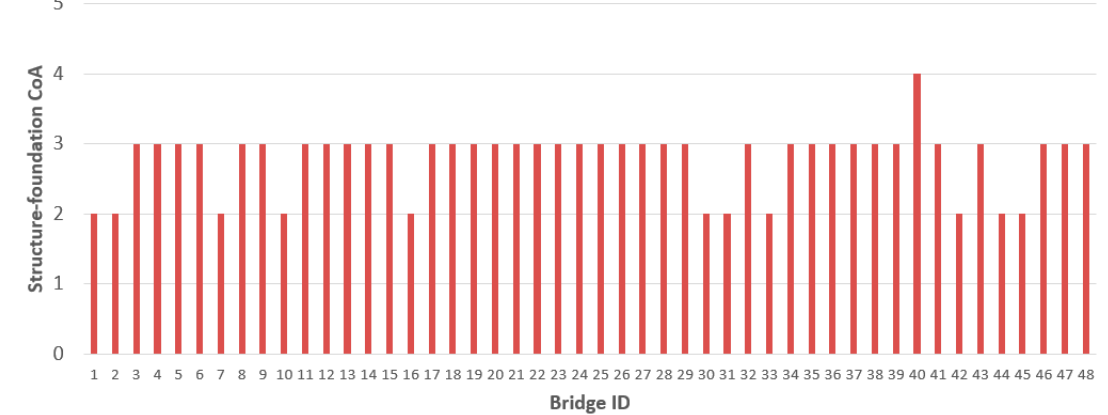
Figure 13. Structure-foundation CoA.